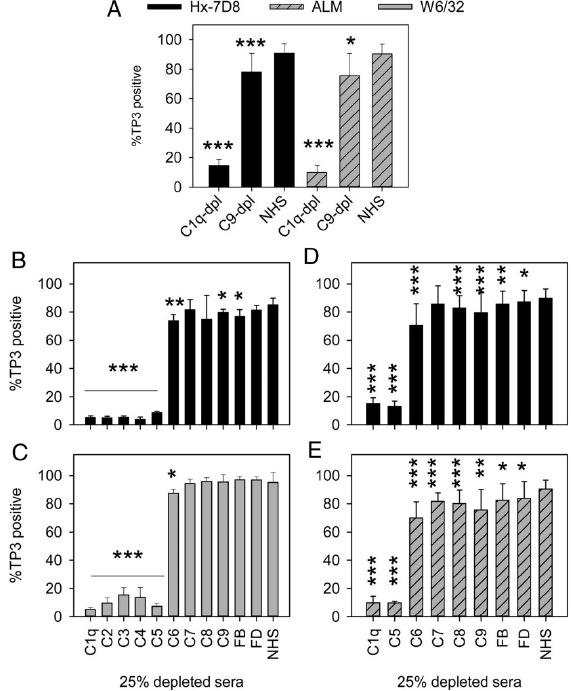
Figure 13. C9-depleted sera support CDC mediated by several different mAbs. Sera depleted of one of several terminal (but not upstream) classical pathway complement components support CDC mediated by several different mAbs. ( A ) mAbs Hx-7D8 and ALM promote robust CDC of CLL cells after reaction for 15 min in 25% NHS or C9-dpl sera. The results are the average for duplicate determinations on cells from eight different CLL patients for Hx-7D8 and the average for cells from four of the eight patients for ALM; means and SD are displayed. No CDC is observed if Hx-7D8 or ALM is reacted with CLL cells in C1q-dpl sera. Differences between C1q-dpl and C9-dpl versus NHS are significant, as illustrated. ( B , C ) Both Hx-7D8 and W6/32 mediate CDC of Z138 cells in sera depleted of terminal pathway components or of complement factor B (FB) or complement factor D (FD). n = 4–6. Significant differences versus NHS are noted. ( D , E ) Both Hx-7D8 and ALM mediate CDC of CLL cells in sera depleted of terminal pathway components or of FB or FD. The averaged results for duplicate determinations on cells from eight different CLL patients are provided. The results for C1q-dpl, C9-dpl, and NHS are the same as in ( A ), and are repeated to allow for ready inspection and comparison with the other depleted sera. * p < 0.05, ** p < 0.01, *** p < 0.001. Figures 11–13 were originally published in The Journal of Immunology . Cook, E. M. et al. 2016, Antibodies that e ffi ciently form hexamers upon antigen binding can induce complement-dependent cytotoxicity under complement-limiting